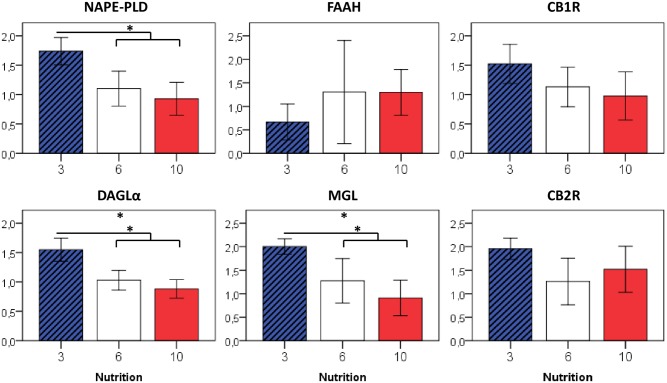
Relative gene expression of eCB-metabolizing enzymes in visceral (perigonadal) adipose tissue at P50 in relation to early postnatal nutrition.n = 4–6 males per nutrition group, * p<0.05 (ANOVA).